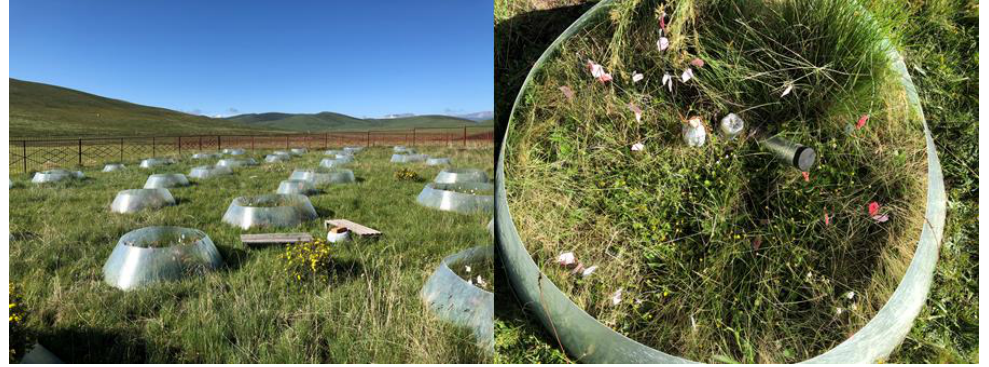
Figure 9. Map of treatment plots and OTC samples.